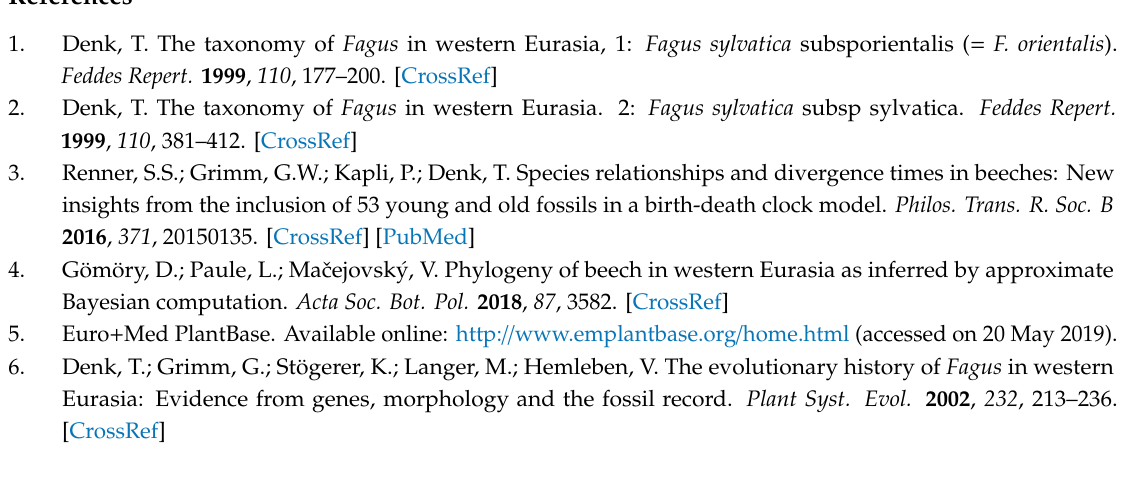
Figure S1: Electropherogram showing alleles 189 and 192 of EST-SSR locus Fs_C6785, Figure S2: Plots of delta K (a) and log likelihood for each K (b), Table S1: Primer characteristics, data file S1: Genotypic data used in the